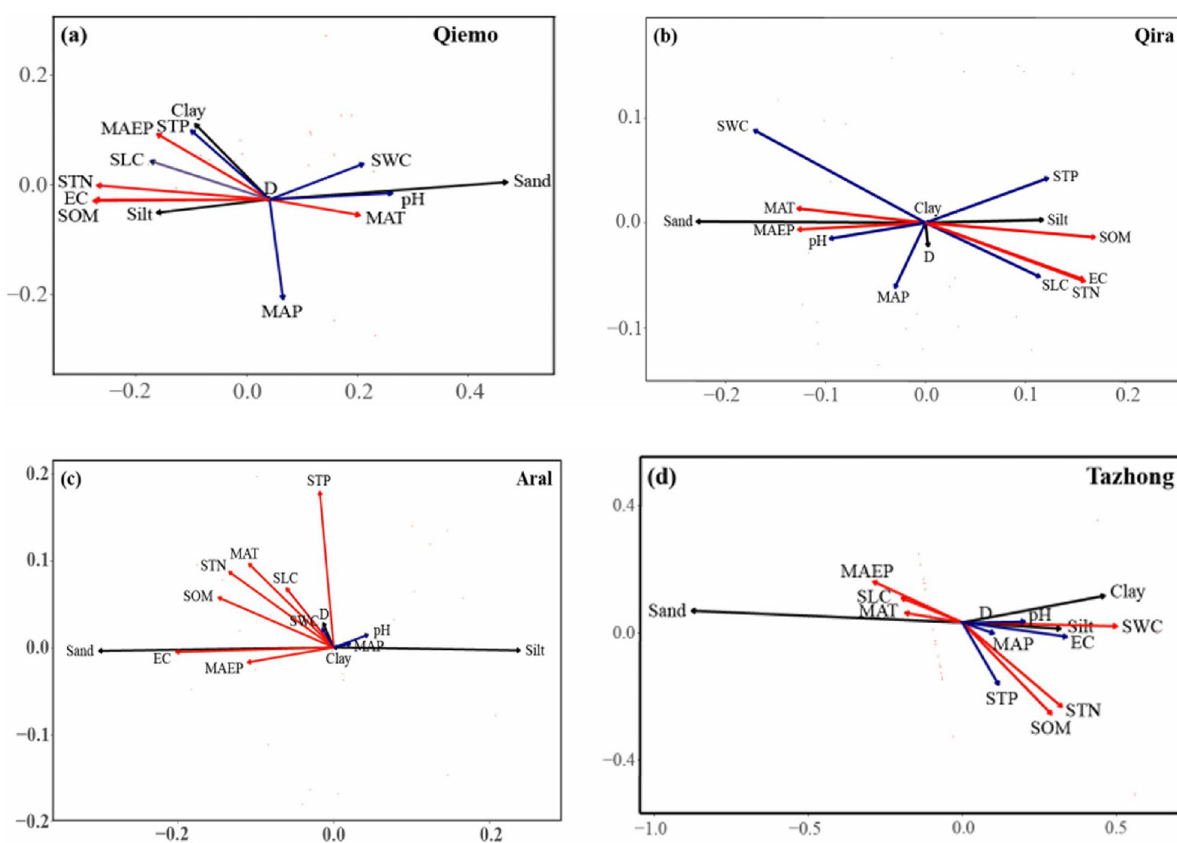
Figure 5. Distance-based redundancy analysis (db-RDA) biplot of soil grain size distribution and environmental factors (MAT, MAP, MAEP, SOM, STN, STP, SLC, SWC, EC, and D represent mean annual temperature, mean annual precipitation, mean annual evaporation, soil organic matter, soil total nitrogen, soil total phosphorus, soil litter content, soil water content, electrical conductivity, and fractal dimension,